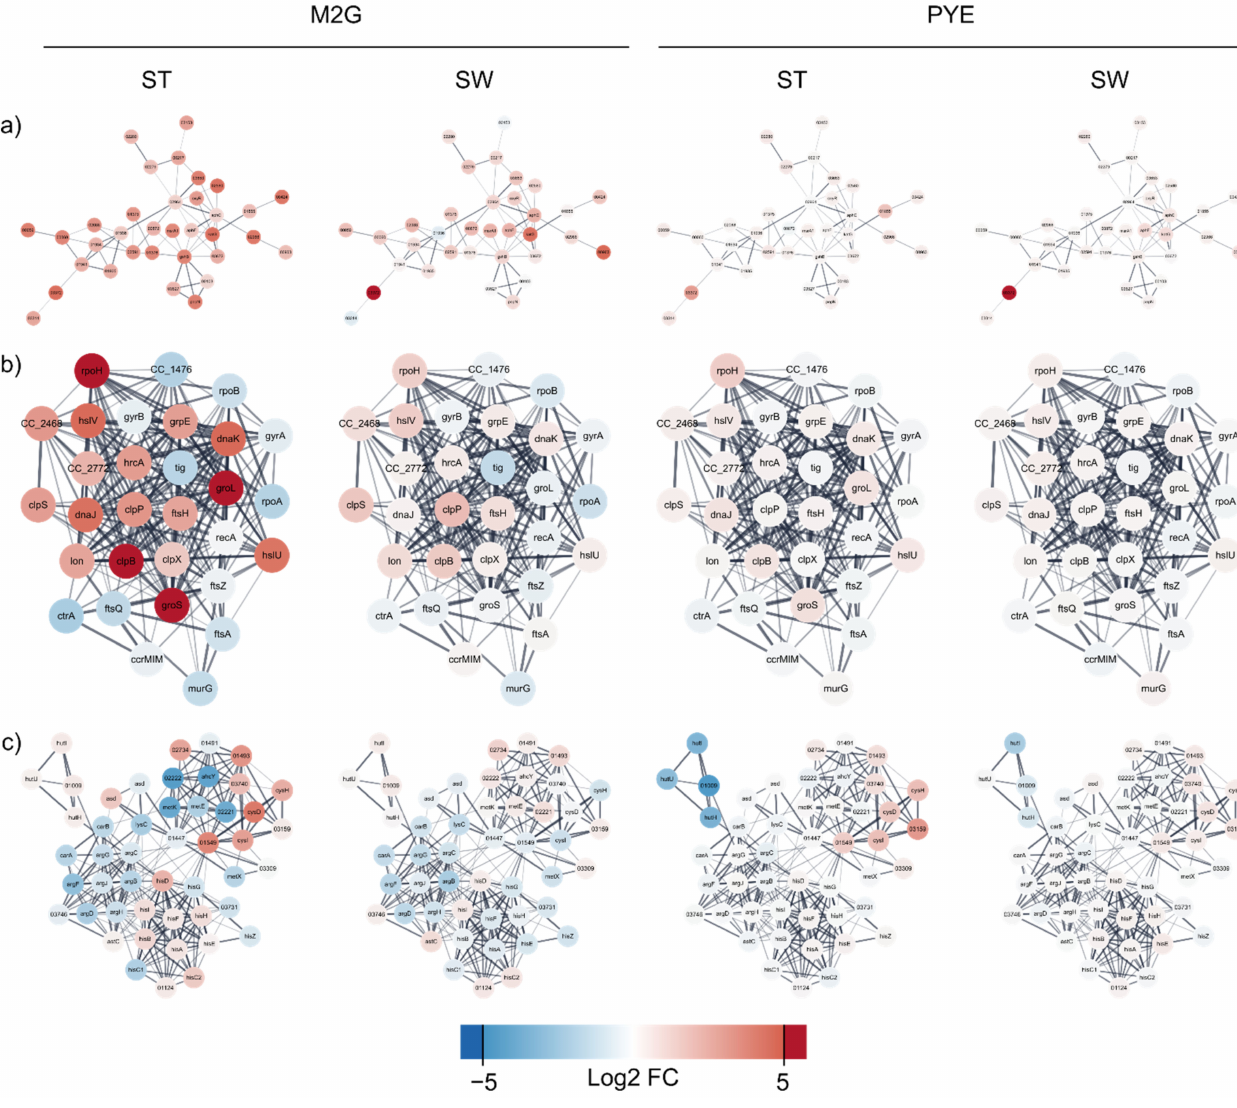
Figure 7. Analysis of interacting gene networks related to oxidative stress ( a ), protein misfolding, proteome rearrangement and chaperones ( b ), and the amino acid metabolism ( c ) of the C. crescentus differentially expressed gene dataset. Color coding is based on log2 fold change in Cu